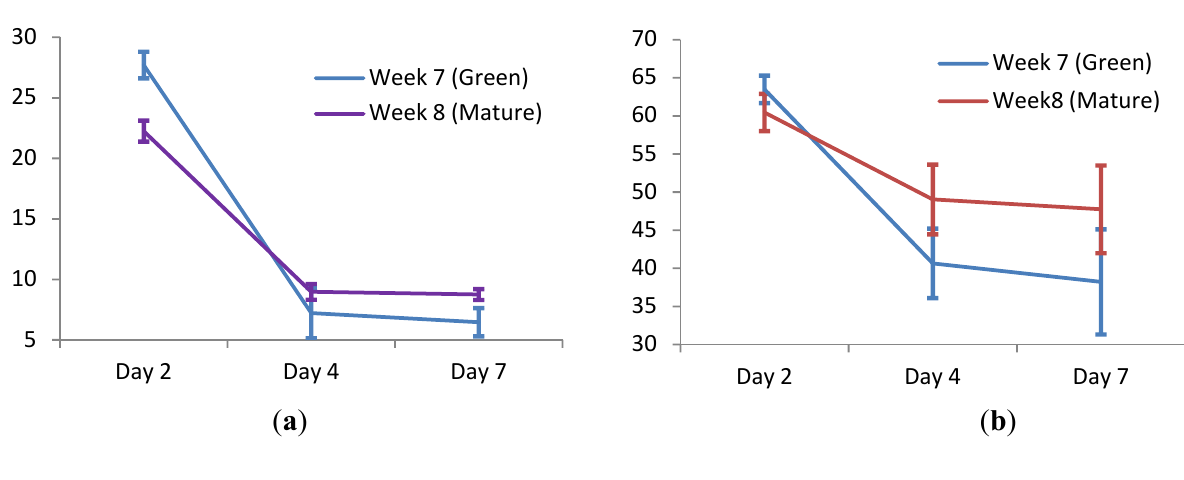
Figure 6. ( a ) Firmness Index (FI) and ( b ) Alternative Firmness Index (AFI) plot of mangoes harvested at Week 7 (Green) and Week 8 (Mature) on three different